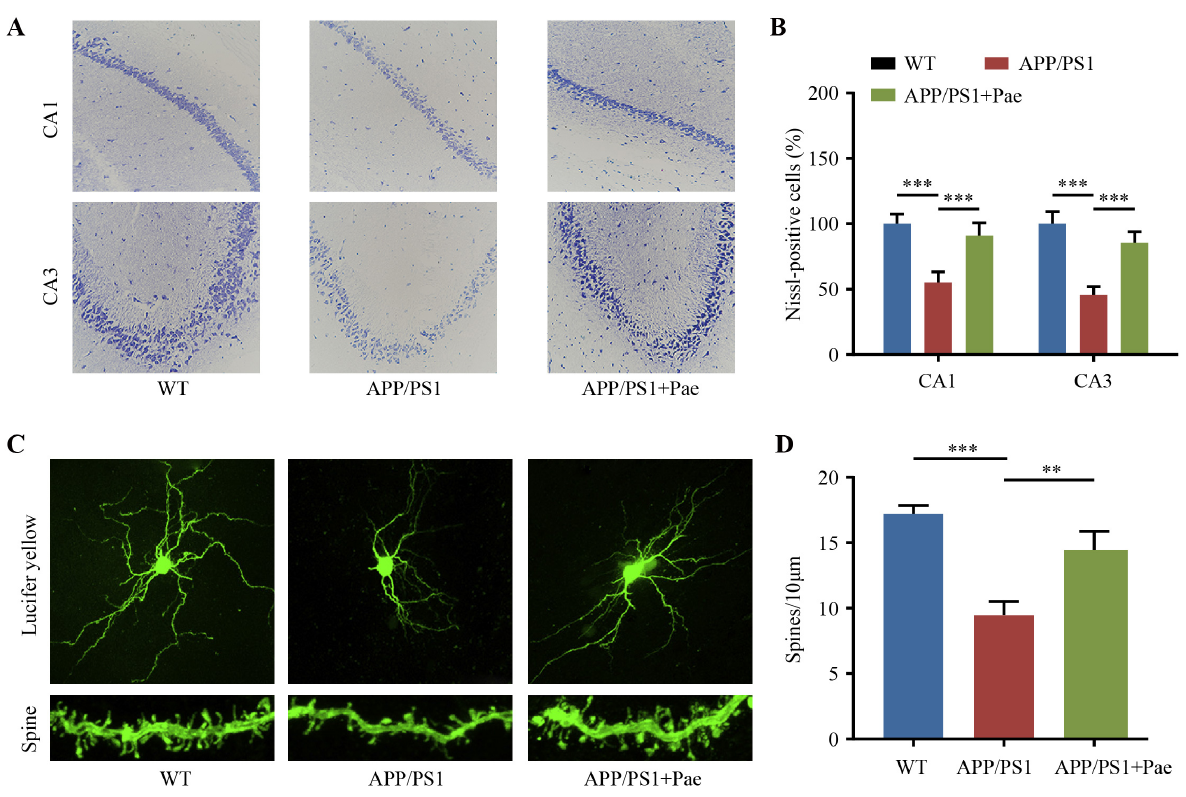
Fig.4. PaeonoltreatmentinhibitedneuronaldamageinthehippocampusofAPP/PS1mice. (A)NisslstainingresultsofthehippocampalCA1andCA3 regions. (B) Quantification of Nissl-positive dead cells in the hippocampus of CA1 and CA3 regions. (C) Representative photomicrographs of EGFP-labeling in CA1 neurons under treatment with Paeonol. Scale bar: 10 µ m. (D) Quantification of the density of dendritic spines from randomly selected dendritic segments of neurons. Mean ± SEM was shown (n = 5 mice). ** p < 0.01, *** p <